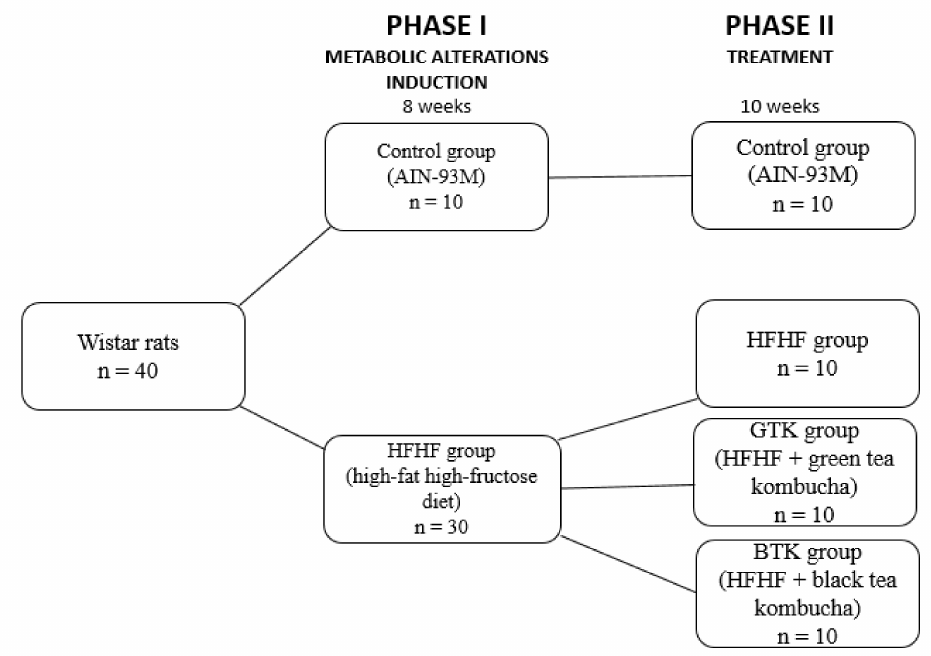
Figure 1. Experimental study